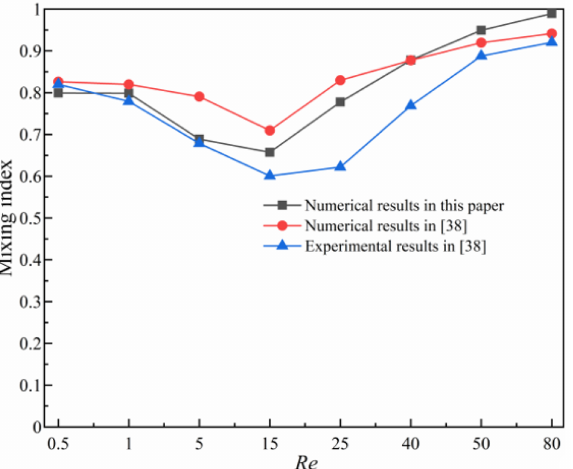
Figure 5. Comparison of numerical results of mixing index with results in